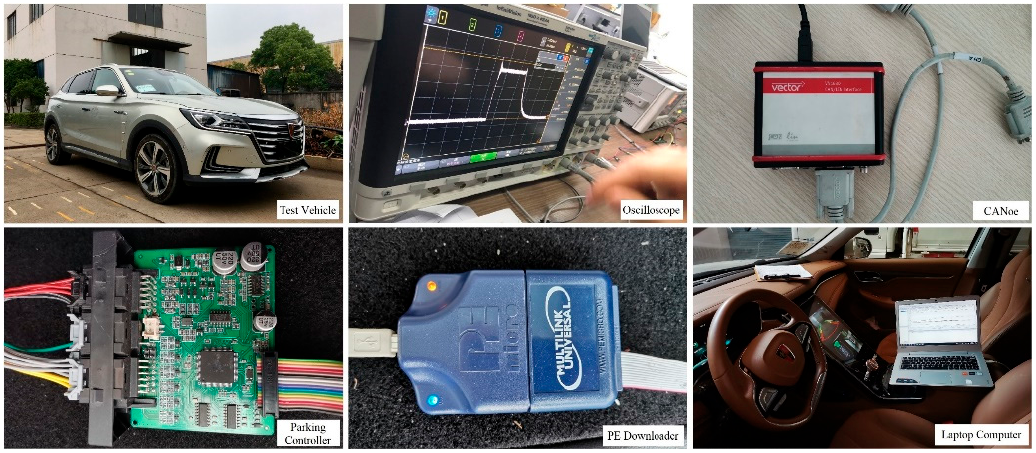
Figure 21. Real Vehicle Test Equipment.